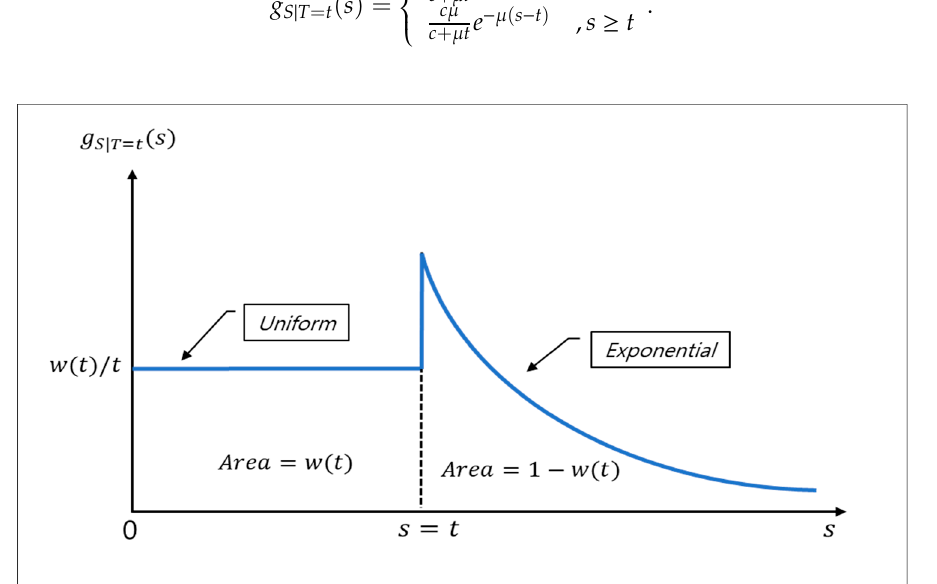
Figure 3. Conditional probability density function g S | T = t ( s ) of detection time s , given t of the failure occurrence time T